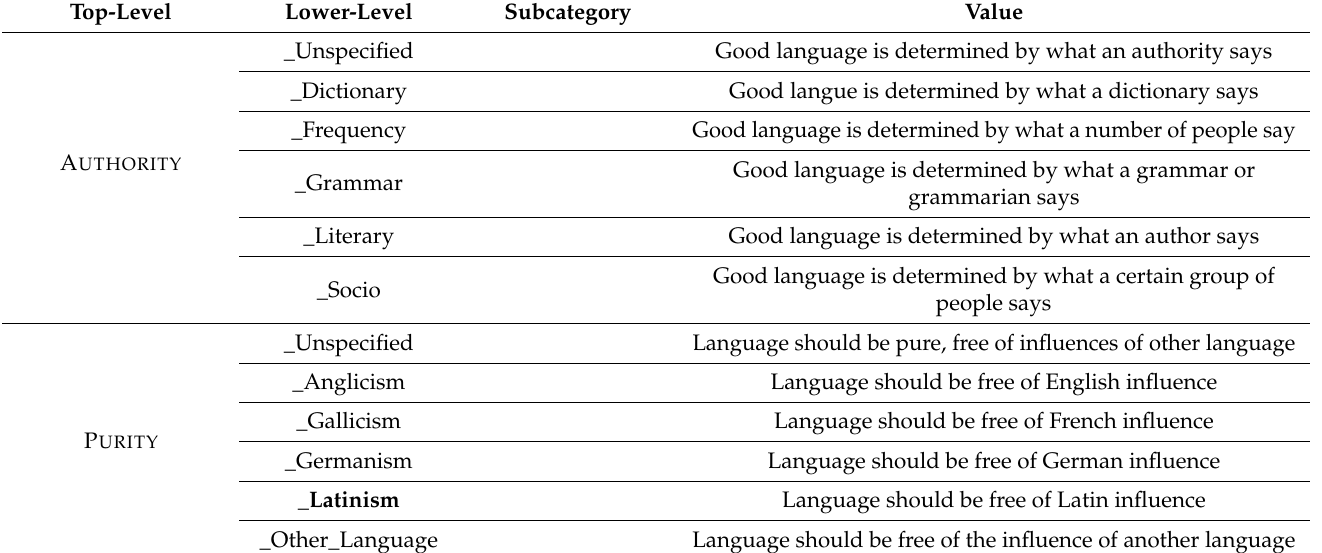
Table 1. Annotation schema for arguments with underlying values, adapted from Van der Meulen (2020) (newly added tags in